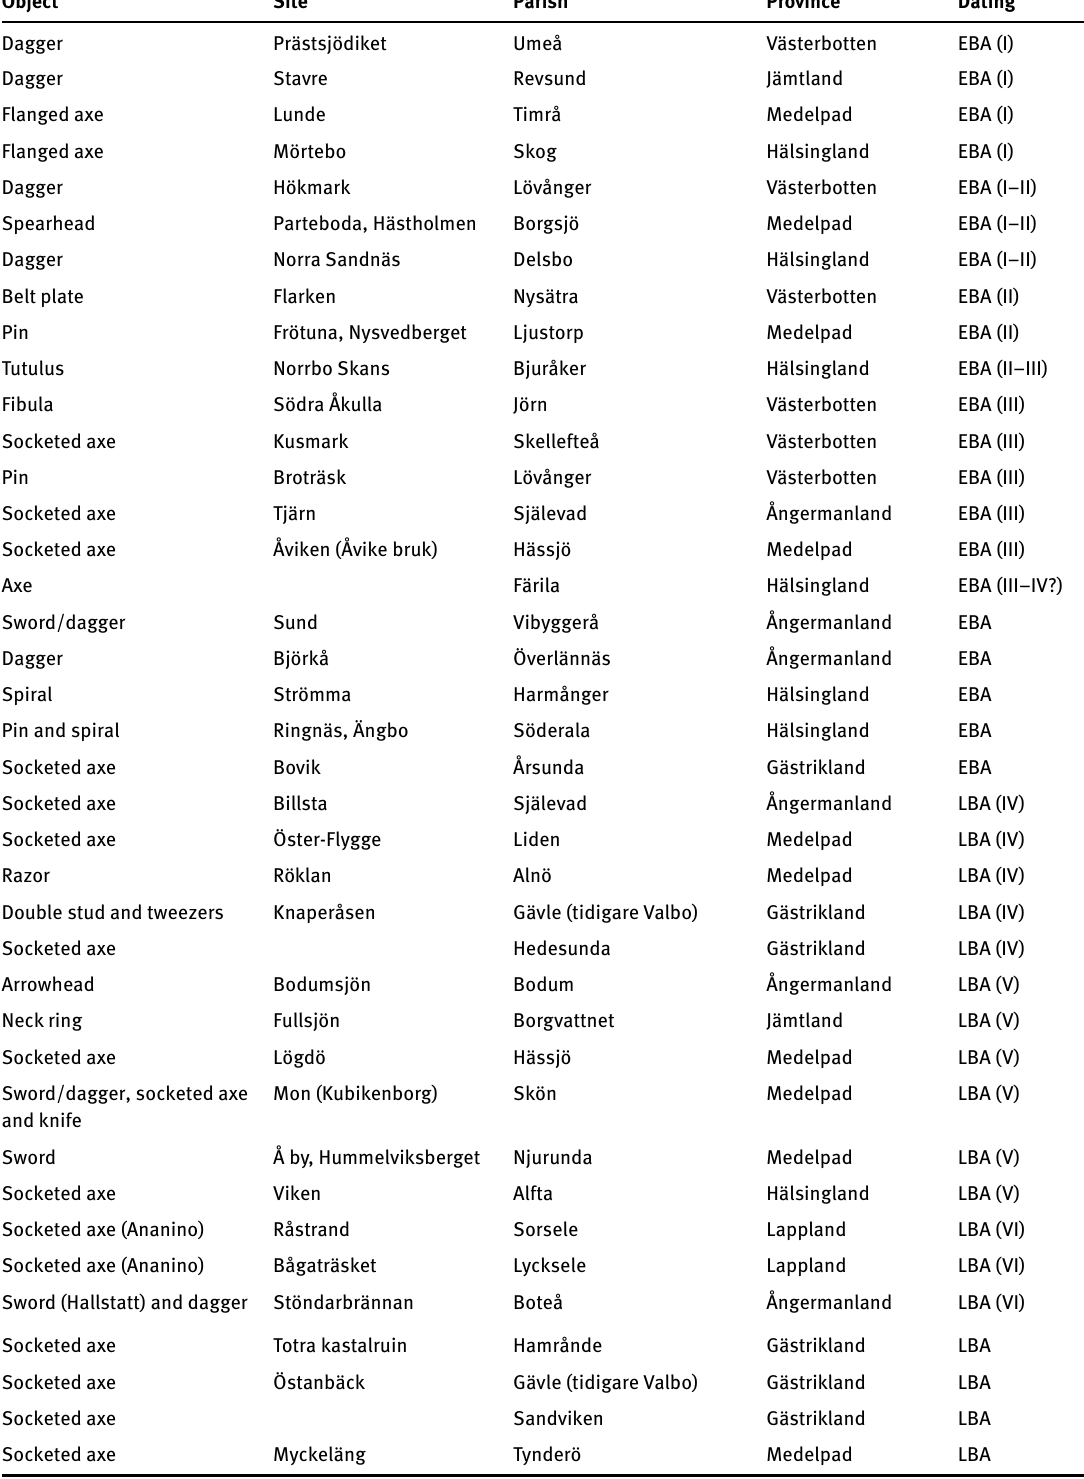
Table 1: Bronze artefacts found in northern Sweden, dating from the Early and Late Bronze Age. Based on information from Larsson